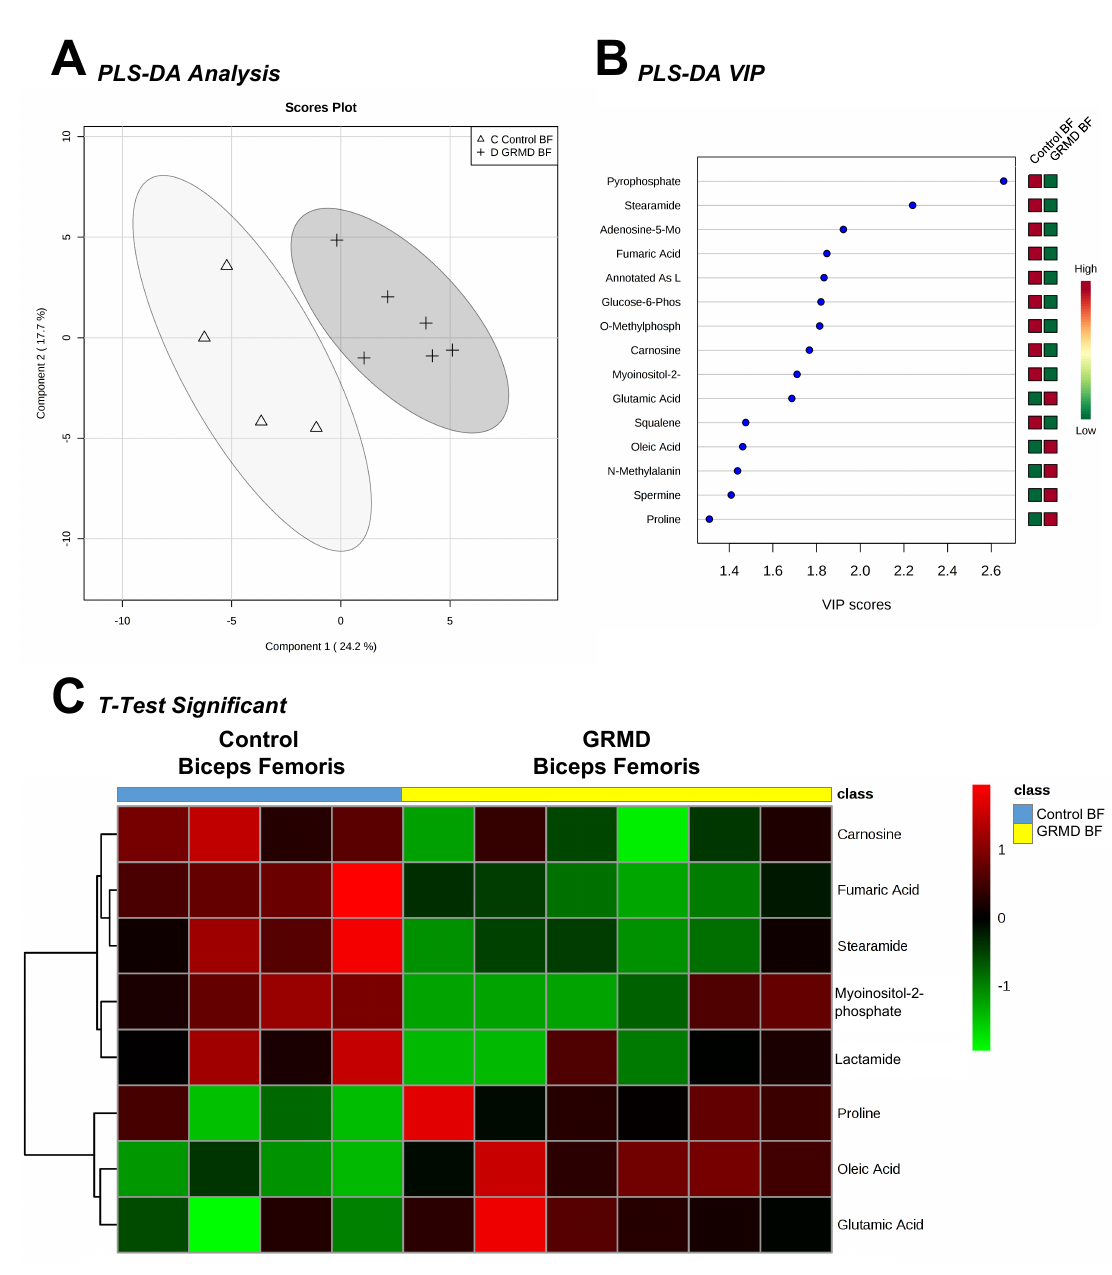
Figure 1. Untargeted metabolomics analysis of golden retriever muscular dystrophy (GRMD) biceps femoris (BF) muscle. ( A ) Supervised clustering of GRMD BF metabolites using Partial least squares Figure 1. discriminant analysis (PLS-DA); ( B ) The top metabolites ranked by VIP scores; ( C ) Heatmap of t -test significant metabolites identified in GRMD BF vs. age-matched controls. Analysis by Metaboanalyst analysis of GRMD (N = 6) vs. control (N = 4) BF